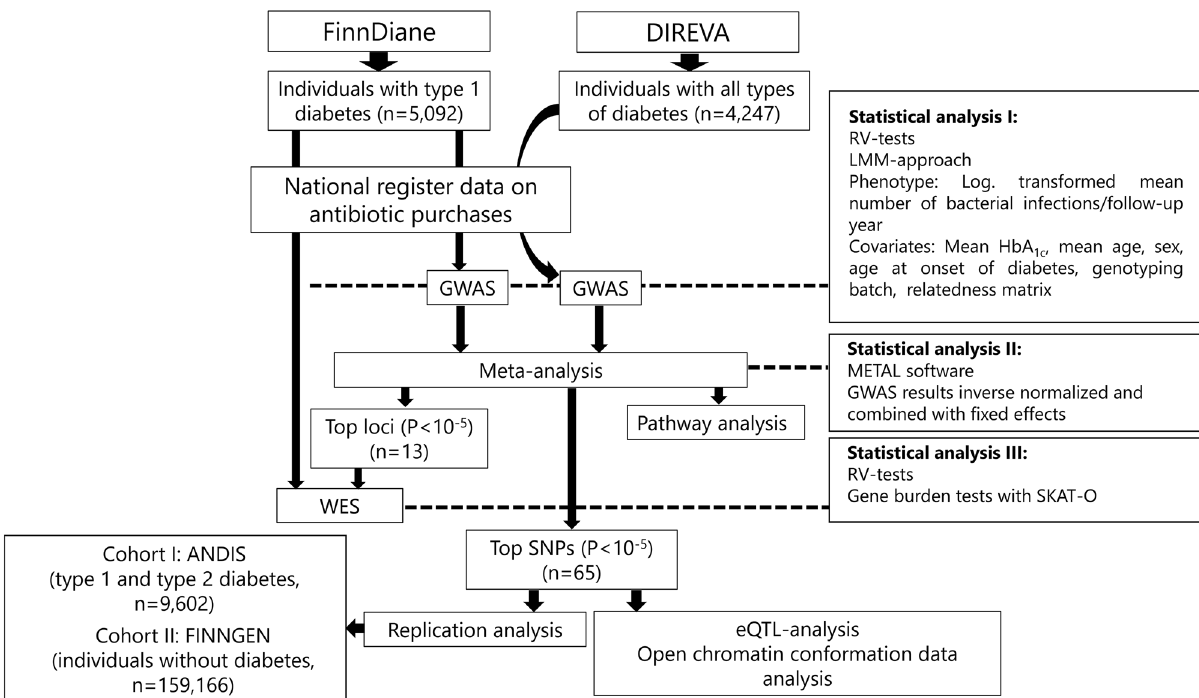
Figure 4. Flow chart summarizing the study design. FinnDiane Finnish Diabetic Nephropathy study, DIREVA Vaasa Diabetes Registry, ANDIS All New Diabetics In Scania, GWAS Genome Wide Association Study, SNP Single Nucleotide Polymorphism, WES Whole Exome Sequencing, eQTL Expression quantitative trait loci, LMM-approach linear mixed model approach, HbA 1c glycated haemoglobin, SKAT-O Sequence Kernel Association Optimal Unified